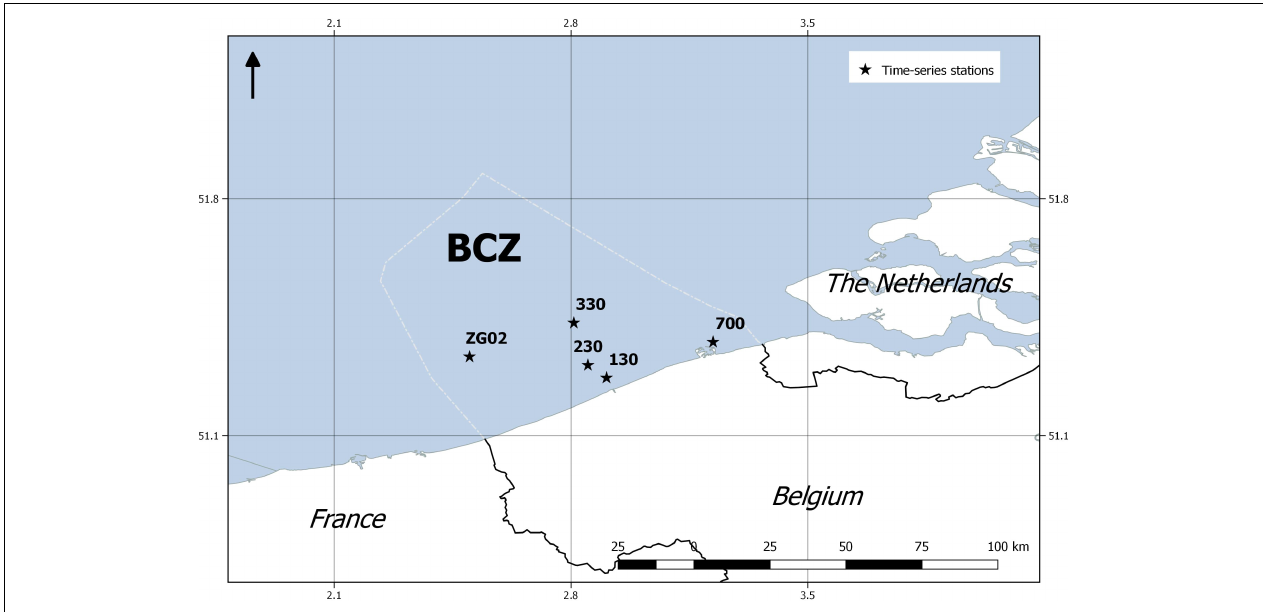
FIGURE 1 | Field sampling locations in the Belgian Coastal Zone accessed using the RV Simon Stevin during years 2018–2019.